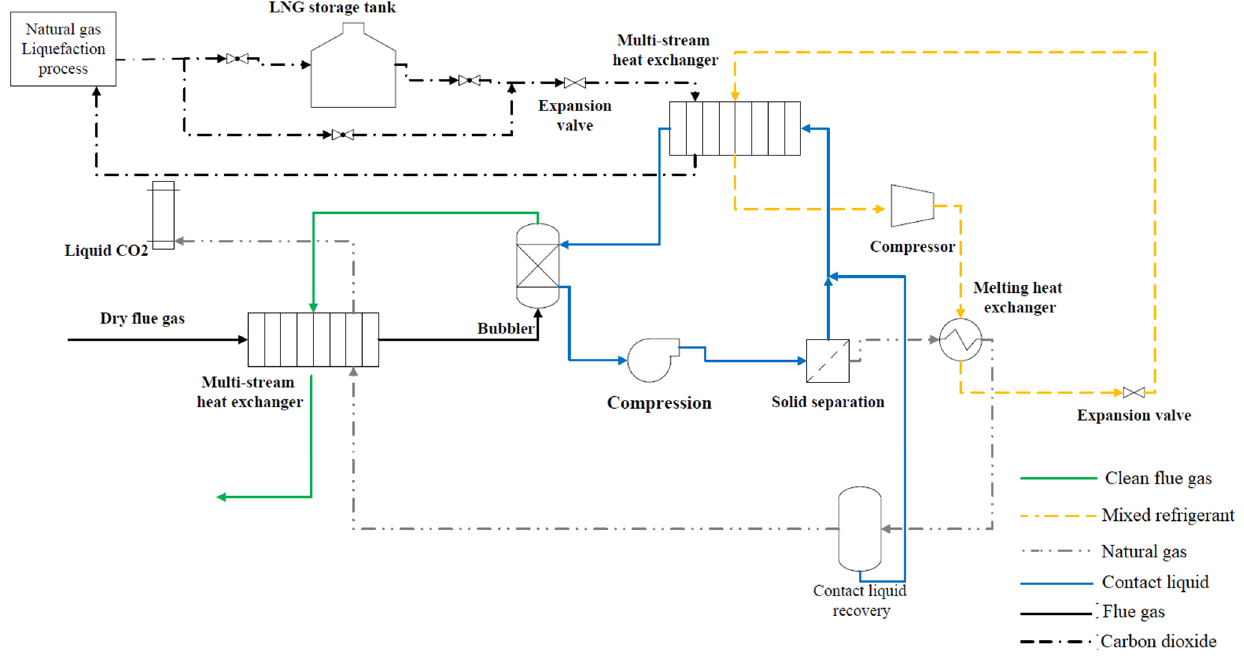
Figure 2. A simplified schematic of the CCC process based on reference [8,23].